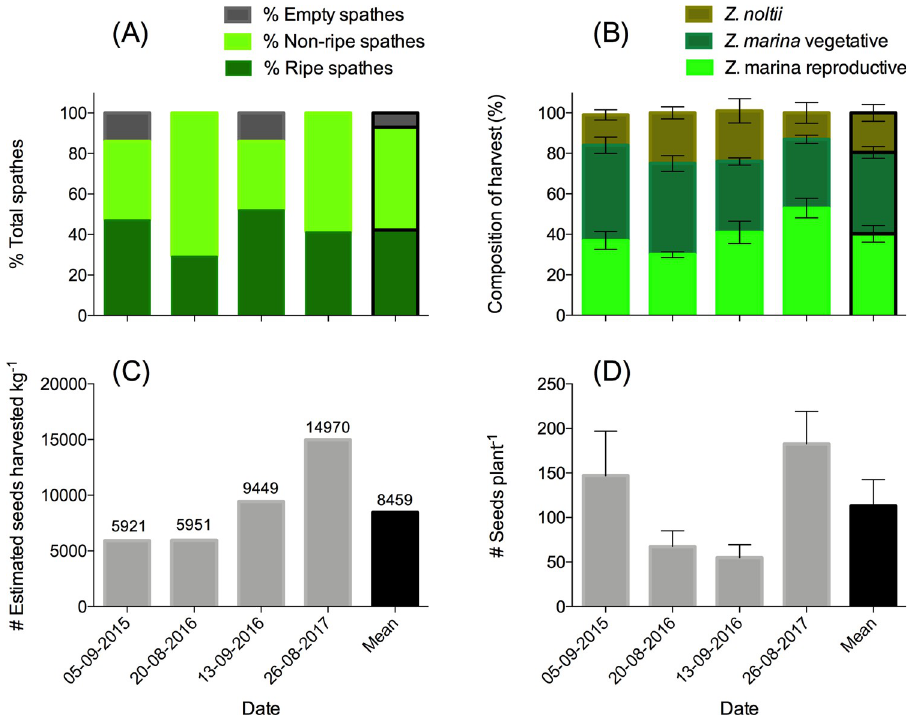
Fig 2. Measurements from the seed donor site on Sylt. (A) Spathe composition per plant with spathes containing ripe seeds at time of harvest (% ripe spathes), spathes containing flowers or developing seeds (% non-ripe spathes) and spathes which have already shed seeds (% empty spathes), (B) Composition of harvested seagrass material divided into seed-bearing spathes of Z. marina, vegetative (leaf, rhizome, root) material of Z . marina , and accidentally harvested Z . noltii (whole plant) (n = 4). (C) Number of seeds per harvested kilogram estimated based on measurements on composition of harvest material, the weight per spathe, ration spathes containing ripe/non-ripe seeds and number of ripe seeds/spathe and (D) number of seeds plant -1 during harvest (n =